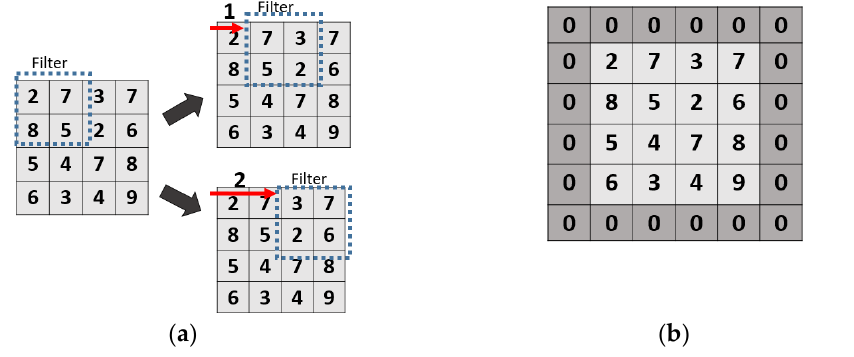
Figure 7. Convolution process: ( a ) stride, ( b ) padding.